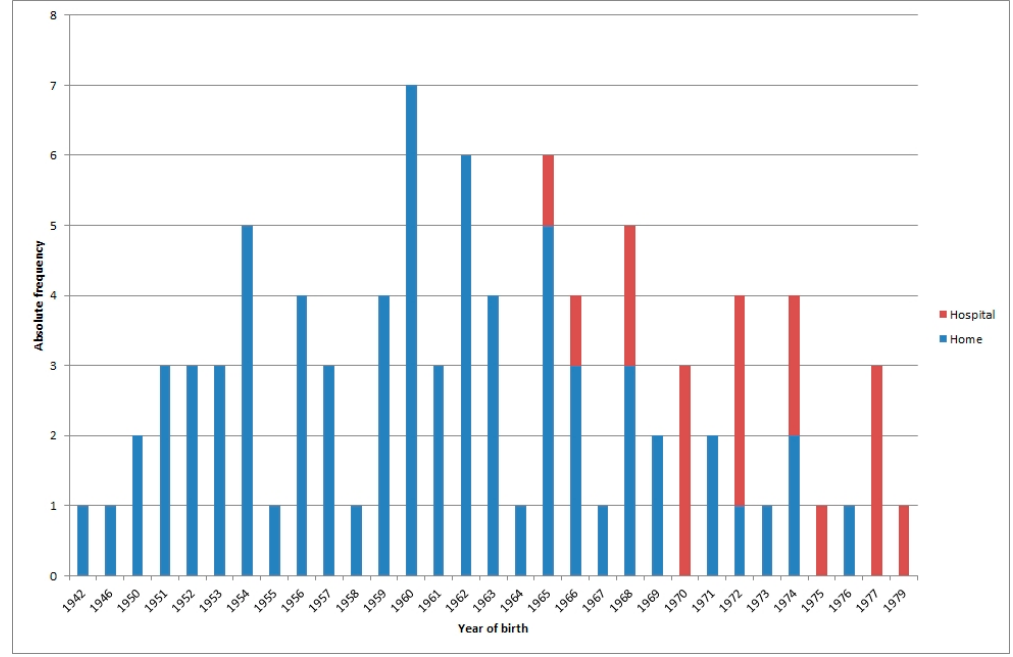
Figure 1. Trends over time in home and hospital births: 1942–1979.